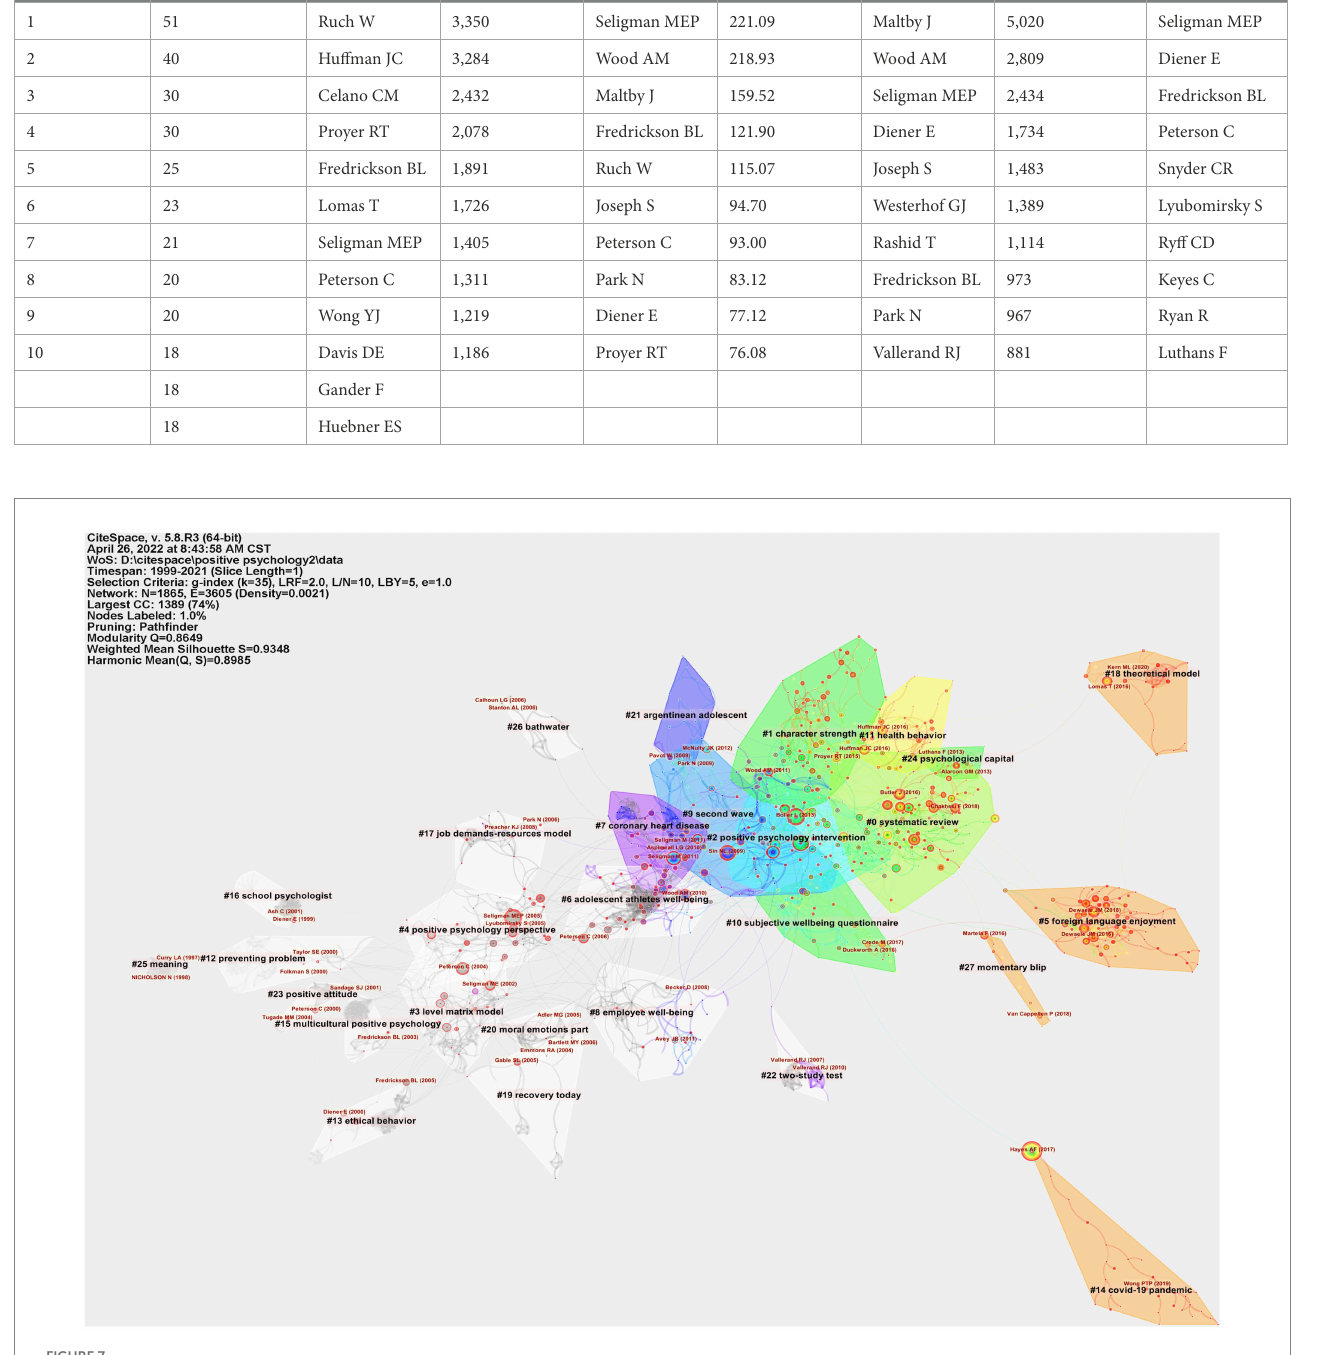
2020). Each cluster had an average silhouette greater than 0.9348 and an overall Q -value of 0.8649, indicating that the quality of the cluster was extremely reliable.